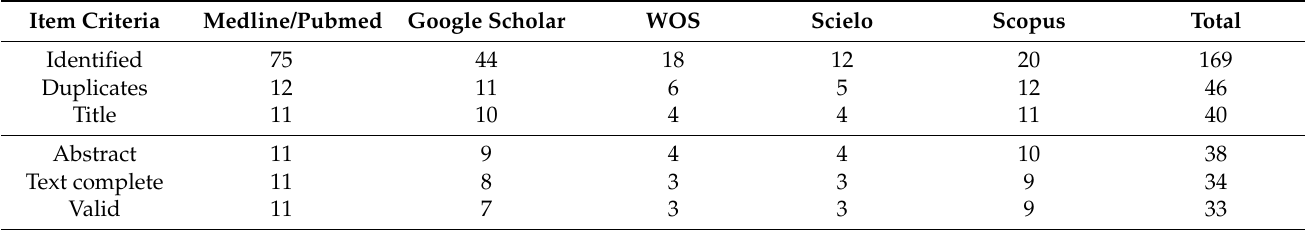
Table 1. Databases Table 1. Databases consulted.